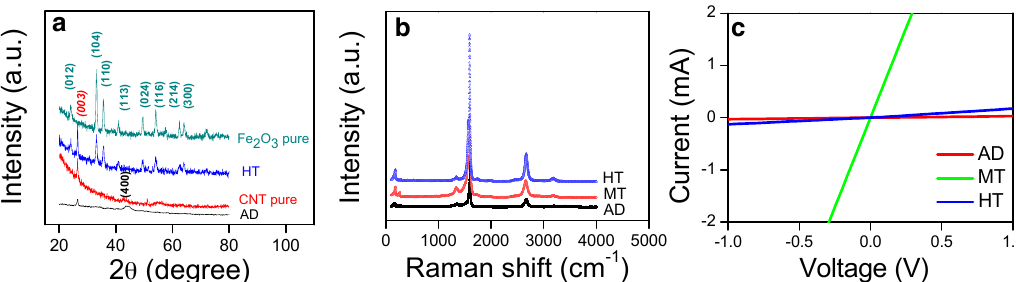
Figure 3. ( a ) XRD patterns of the HT and AD samples along with the pure CNT and Fe 2 O 3 samples. The peaks confirmed Fe, polycrystalline hematite, and graphite. ( b ) Raman spectra of the AD, MT, and HT samples. ( c ) Current versus voltage curves of the AD, MT, and HT composite structures.